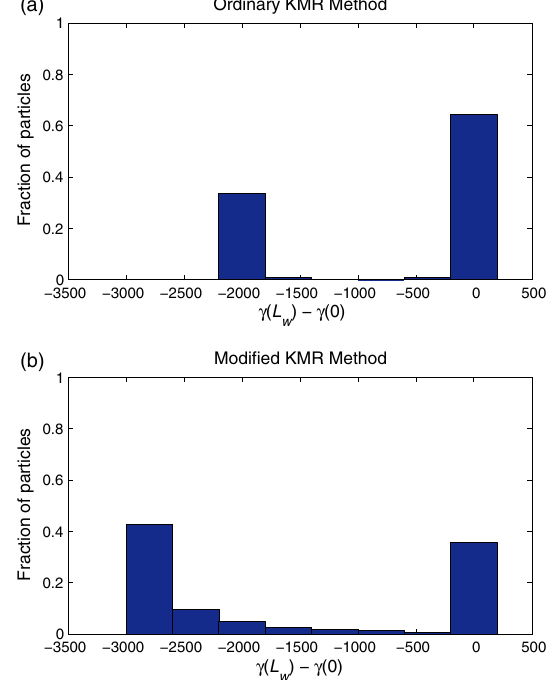
FIG. 4. Histograms showing the particle energy distributions at the end of the undulator line for the (a) ordinary KMR method ¼ 0 . 26 rad) and (b) modified KMR method (with (with ψ R g ¼ 3 mrad =